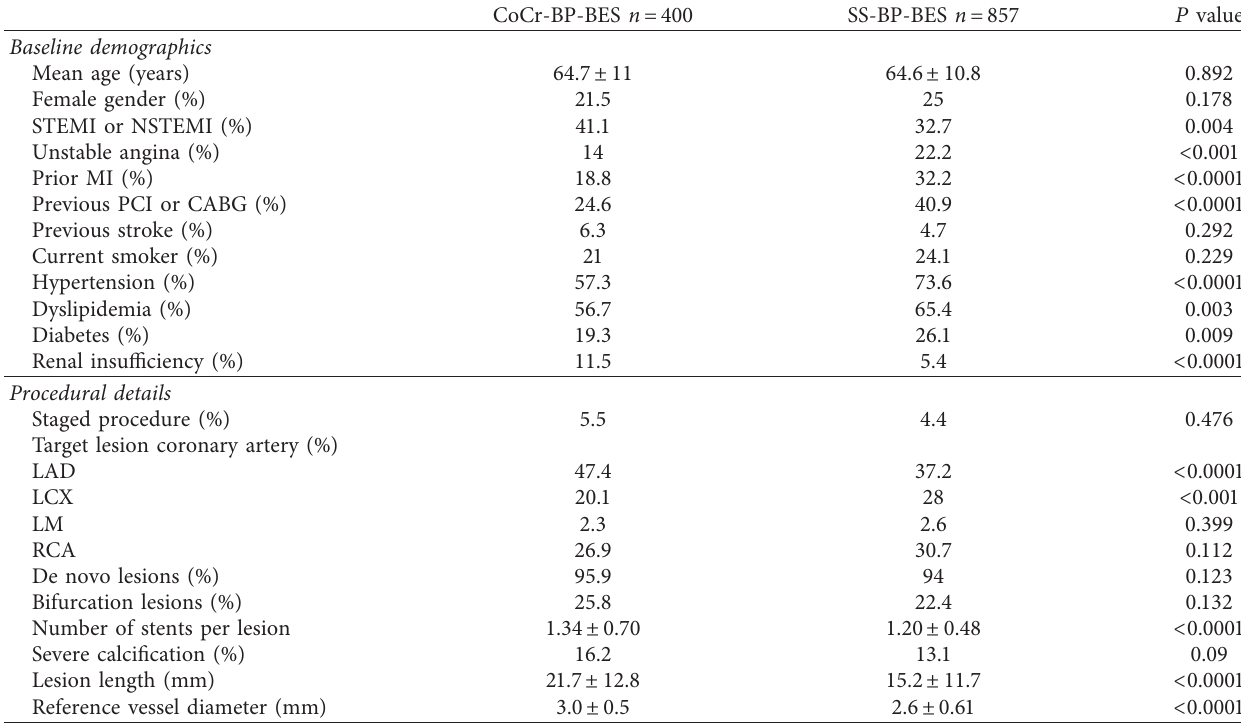
Table 1: Baseline demographics and procedural details.